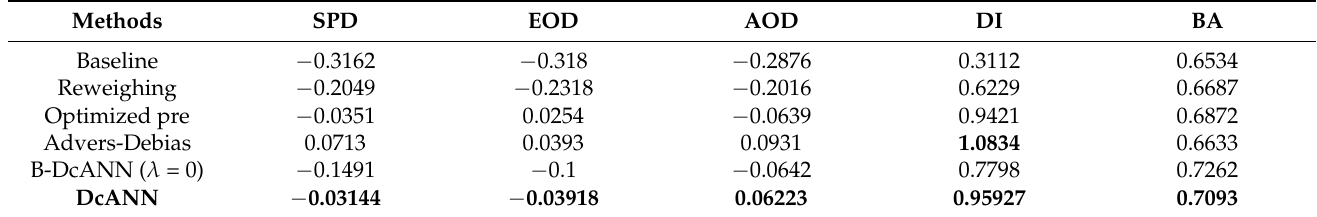
Table 2. Fairness scores and Balanced accuracies of predictions for age-biased German dataset for different